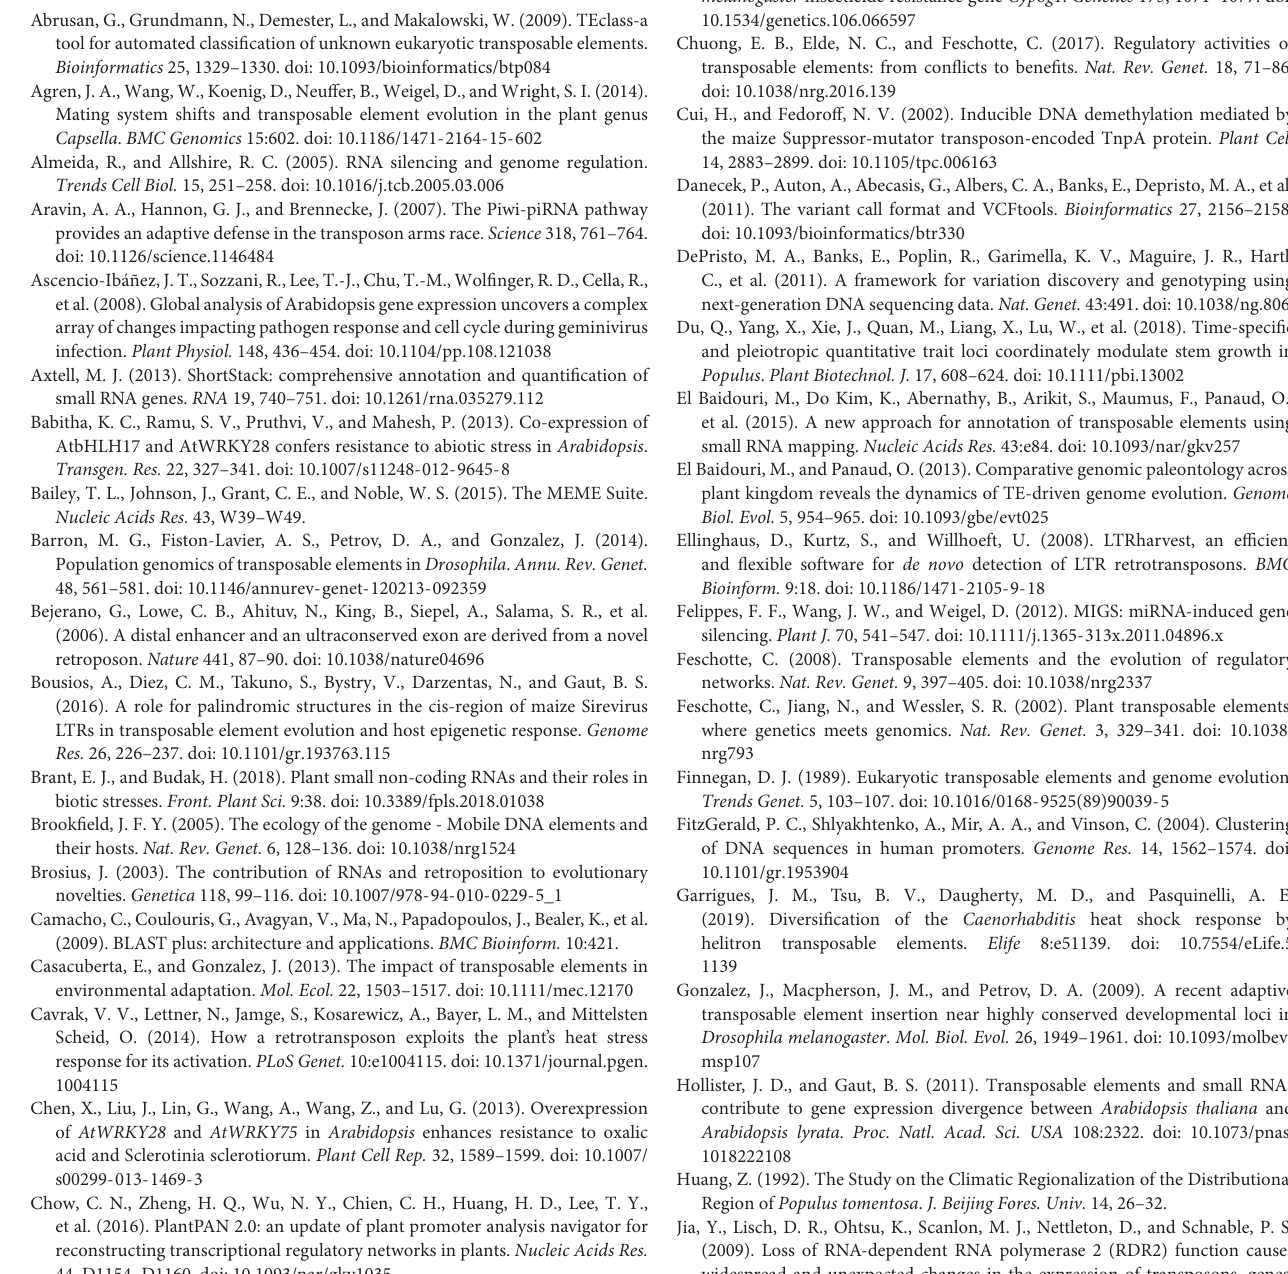
Supplementary Figure 3 | Distribution of TEs in four Populus genomes. Supplementary Figure 4 | GO-term analysis of genes with transposons. Supplementary Figure 5 | Six regulatory motifs significantly enriched in the TEs drive promoter regions. Supplementary Figure 6 | Flowchart of the polymorphic TE.